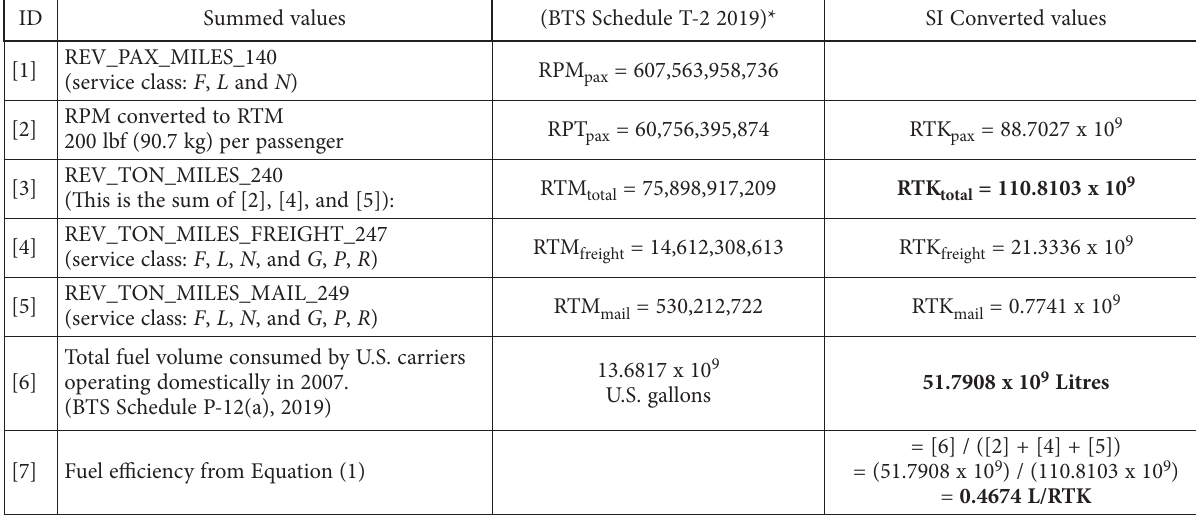
Table 1. RTK and fuel volumes for both scheduled and non-scheduled U.S. air carriers, Domestic region,